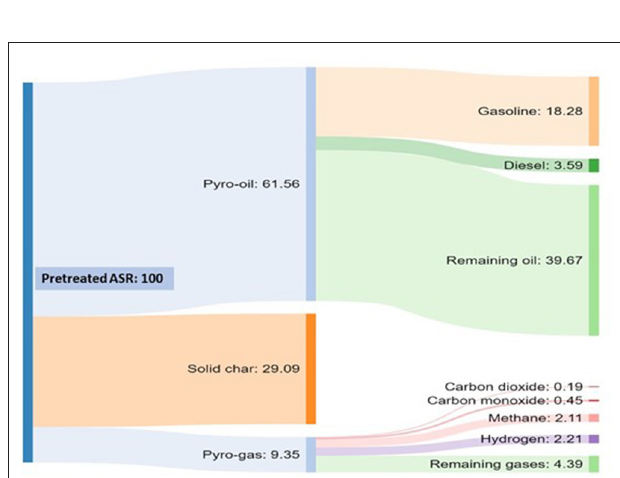
FIGURE 11 | (A) GC-FID analysis of the pretreated ASR pyrolysis oil obtained at 280–350 ◦ C and its distillates. (B) GC-FID analysis of the pretreated ASR pyrolysis oil obtained at 350–500 ◦ C and its distillates.